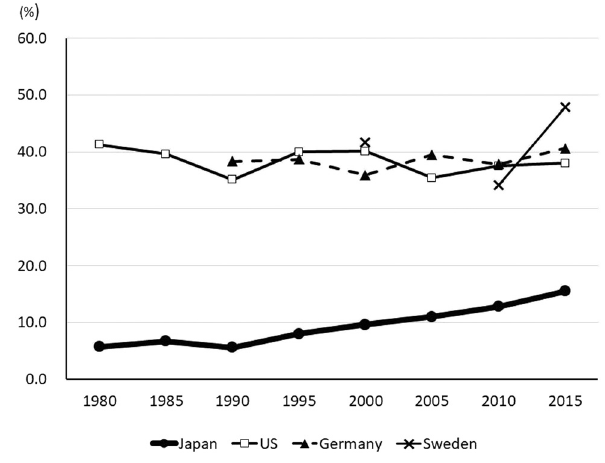
Figure 2: The ratio of single households in percentage. International Comparative Survey on the Lives of Elderly People ( Cabinet O ffi ce, the Government of Japan ) .